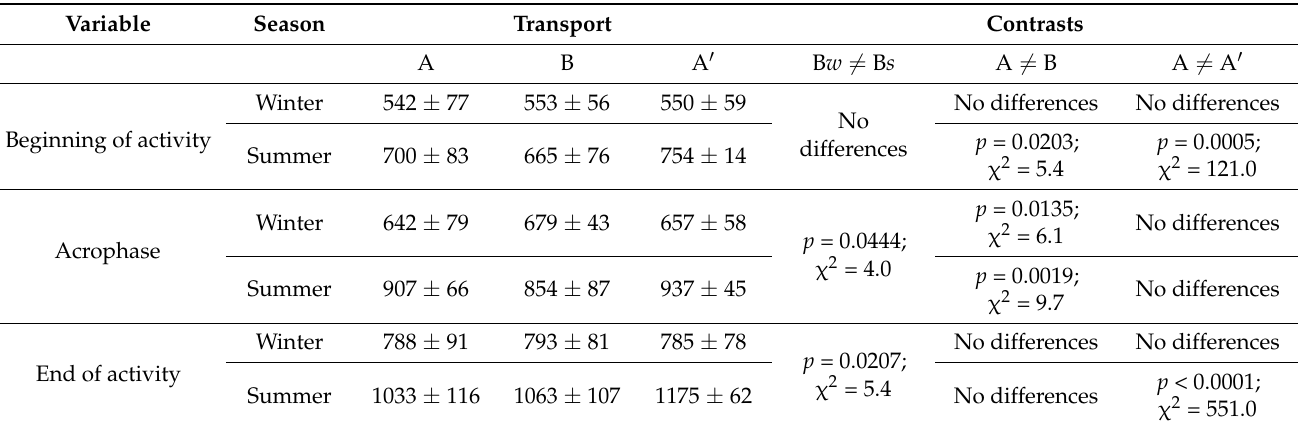
Table 3. Effect of seasonal transport on activity cycle of adult Tamandua tetradactyla maintained in semi-controlled